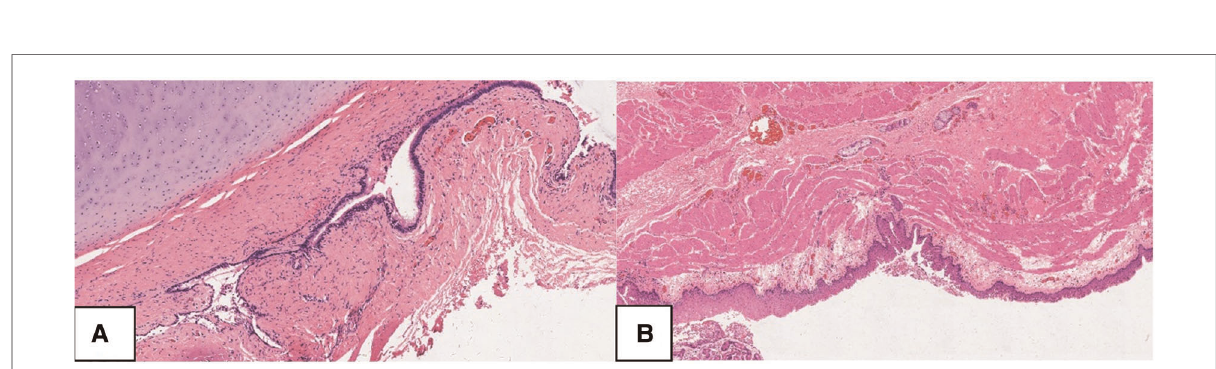
FIGURE 6 Histopathology of bronchogenic cyst. The inner layer of BC originates from the respiratory system and is covered by pseudostrati fi ed columnar ciliated epithelium on the fi brous connective tissue wall, which contains the cartilage plates, ( A . HE, 100X), seromucous glands and smooth muscle ( B . HE, 50X). pseudostrati fi ed columnar ciliated epithelium, PCCE; fi brous connective tissue wall, FCTW; seromucous glands, SG; smooth muscle,